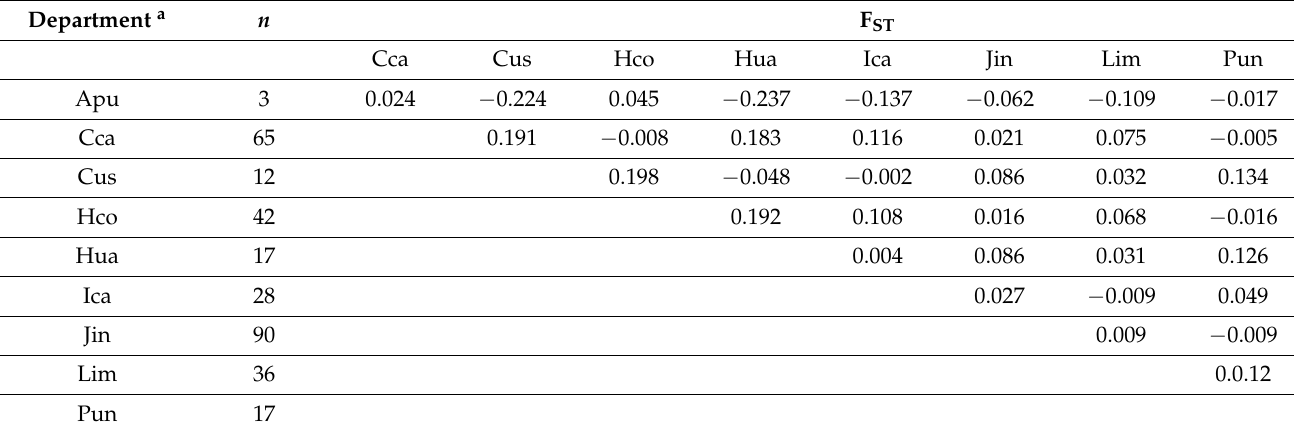
Table 4. Genetic links (gene flow) between the potato virus X concat populations of eight different Peruvian Departments. Department Figure 5. Graph of the number of Peruvian Departments in which an isolate of each potato virus X cluster was found, plotted against the number of isolates in each cluster. Letters A–L stand for the clusters A–L in Table 2 and Figure 2.